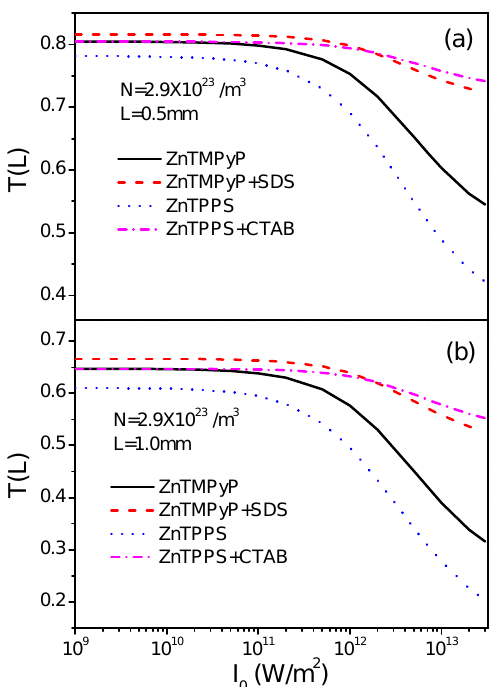
Figure 3. Energy transmittance T ( L ) (Equation (6)) as a function of the peak intensity of incident laser I 0 at ( a ) L = 0.5 mm and ( b ) L = 1.0 mm for ZnTMPyP and ZnTPPS in aqueous solutions and their porphyrin J-aggregates with micelles of SDS and CTAB. N = 2.9 × 10 23 /m 3 .